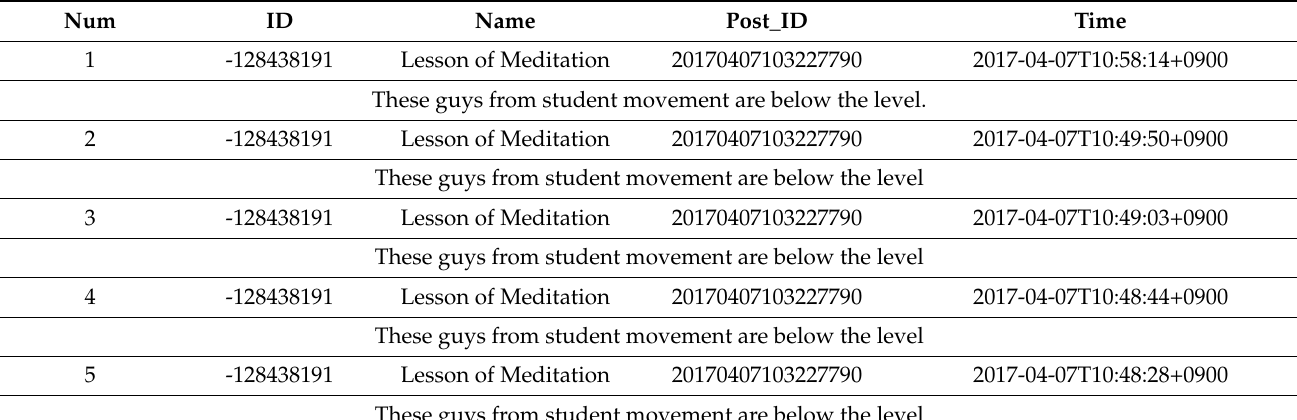
Table 5. Comments of user having the highest similarity score.